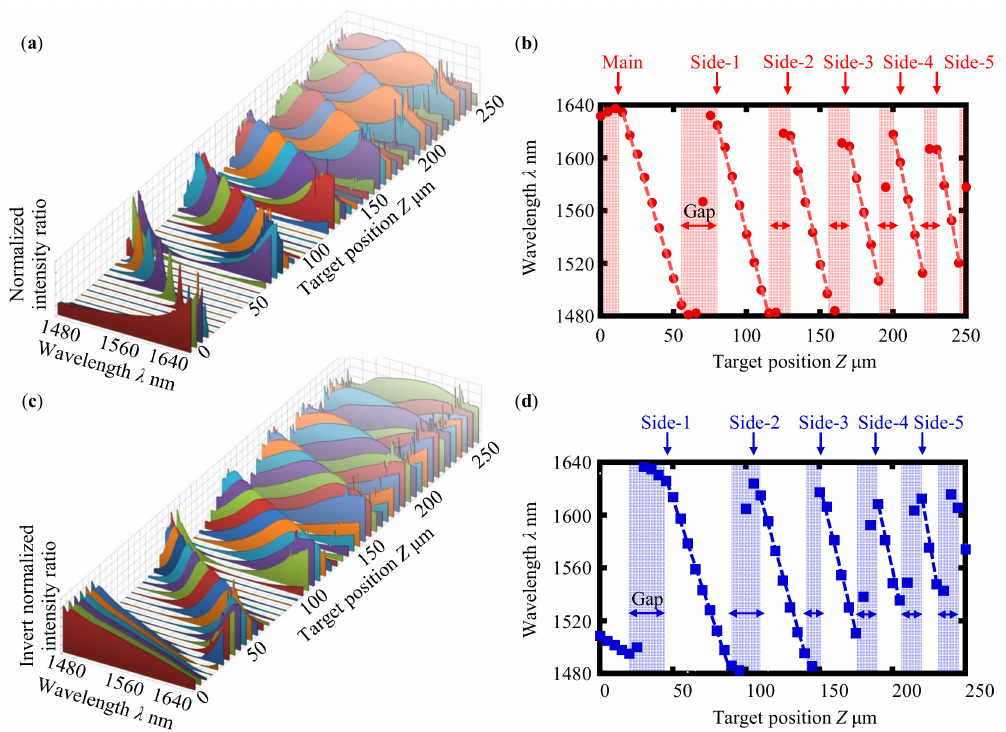
Figure 8. The main-lobes and the side-lobes extracted from the normalized intensity ratio and the invert normalized intensity ratio obtained at each Z-directional position of the plane mirror, with target positions ranging from 0 to 250 µ m and a defocus d of 110 µ m. ( a ) Normalized intensity ratio obtained at each Z-position over scanning range of 250 µ m. ( b ) The lobes extracted from the normalized intensity ratio. ( c ) Invert normalized intensity ratio obtained at each Z-position over scanning range of 250 µ m. ( d ) The lobes extracted from the invert normalized intensity ratio.